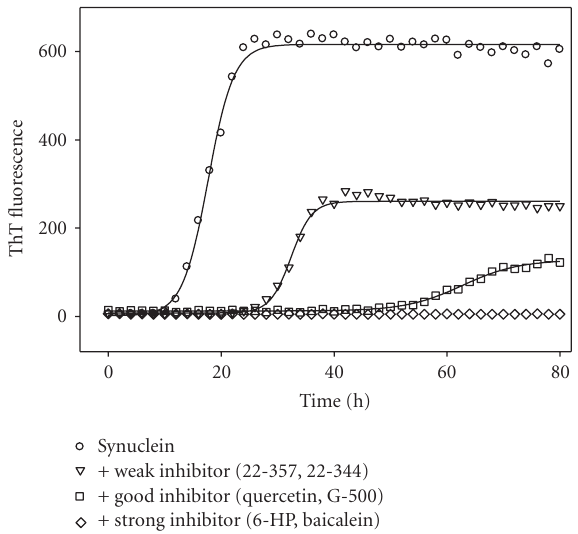
Figure 2: Inhibitory e ff ects of flavonoids on the kinetics of α -synuclein fibrillation. Comparison is made between strong inhibitors (+++), such as 6-HP and Baicalein, good inhibitors (++), such as quercetin and G-500, and weak inhibitors (+), such as 22- 357 and 22-344.